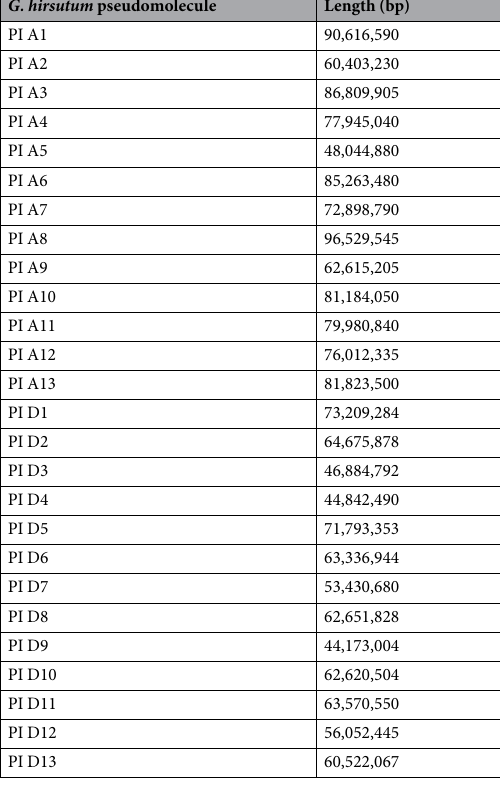
Table 2. G. hirsutum TM-1 PI pseudomolecule lengths.